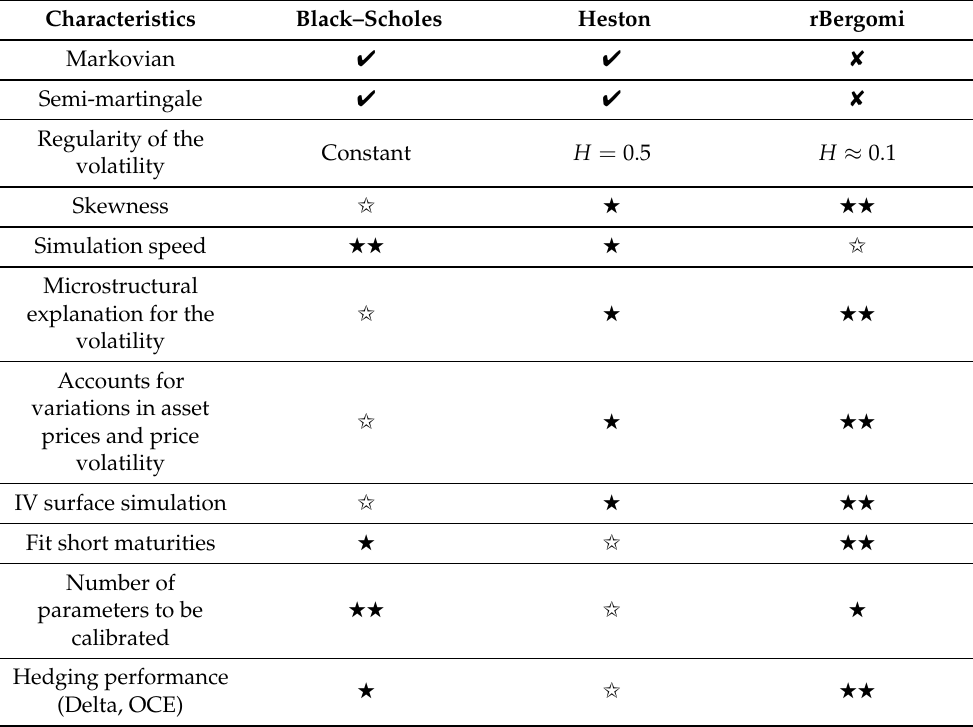
Table 7. Summary of the characteristics of volatility models with different roughness scales.